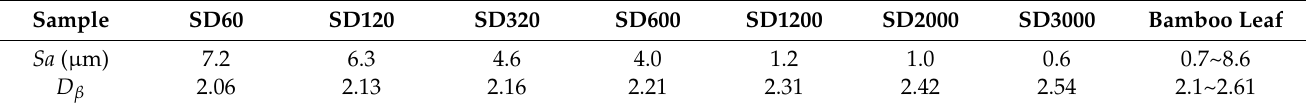
Figure 4. Roughness of Si surface. ( a ) Schematic illustration of roughnesses Ra x , Ra z , and Sa . ( b ) Profiles of the BLHS surface. Table 2. Solid surface roughnesses and fractal dimensions of the sample surfaces by micromachining with different diamond grindings.